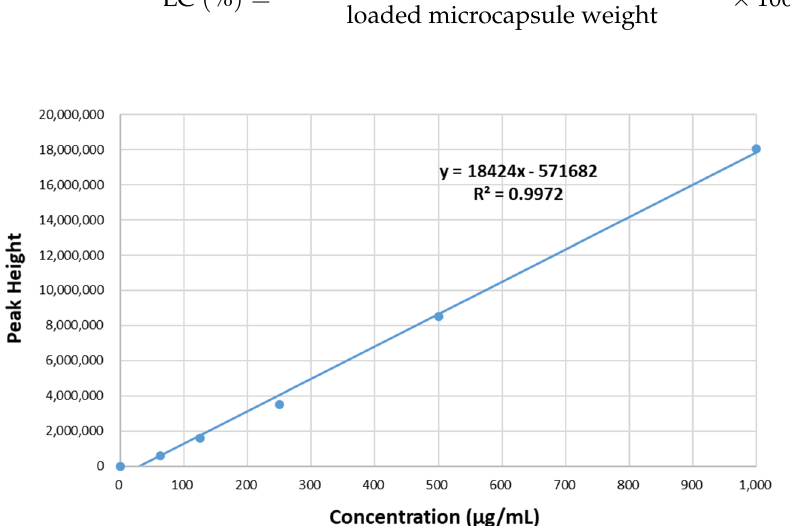
Figure 6. GC-MS calibration curve for standard benzyl isothiocyanate .